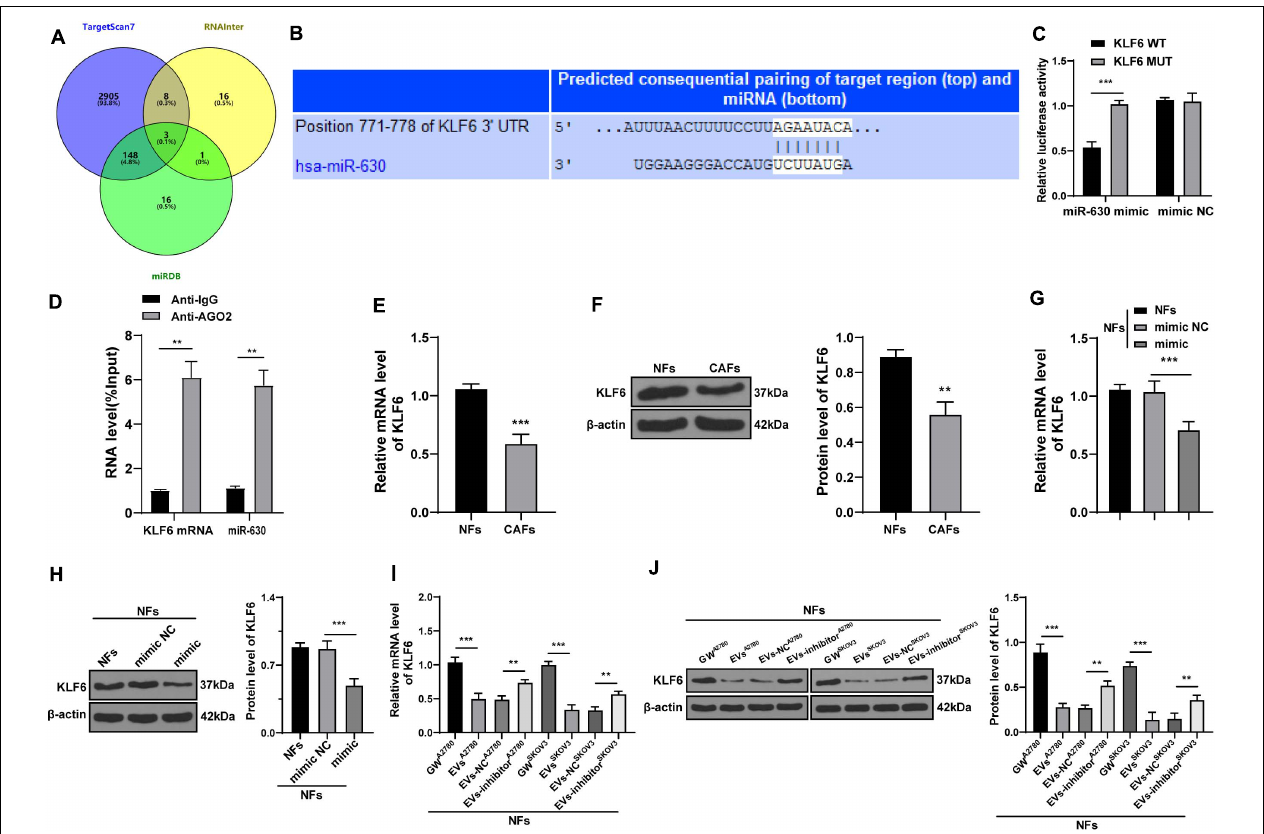
FIGURE 4 | miR-630 targeted KLF6. (A) Target genes of miR-630 were predicted through TargetScan7, RNAInter (Score > 0.70), and miRDB (Score > 70) databases; (B) binding site between miR-630 and KLF6 was predicted through databases; (C) targeting relationship between miR-630 and KLF6 was verified using dual-luciferase reporter gene assay; (D) RIP assay verified the interaction between miR-630 and KLF6 mRNA; (E,F) KLF6 expression in cells in each group was detected using RT-qPCR and Western blotting; (G–J) KLF6 expression in NFs after different treatments was detected using RT-qPCR and Western blotting. The experiment was repeated three times independently. Data are presented as mean ± standard deviation. Data in panel (C–F) were analyzed using t -test, and data in panels (G–J) were analyzed using one-way ANOVA, followed by Tukey’s multiple comparison test, ** p < 0.01, *** p < 0.001. A2780 and SKOV3 in panels (I,J) indicated the source of